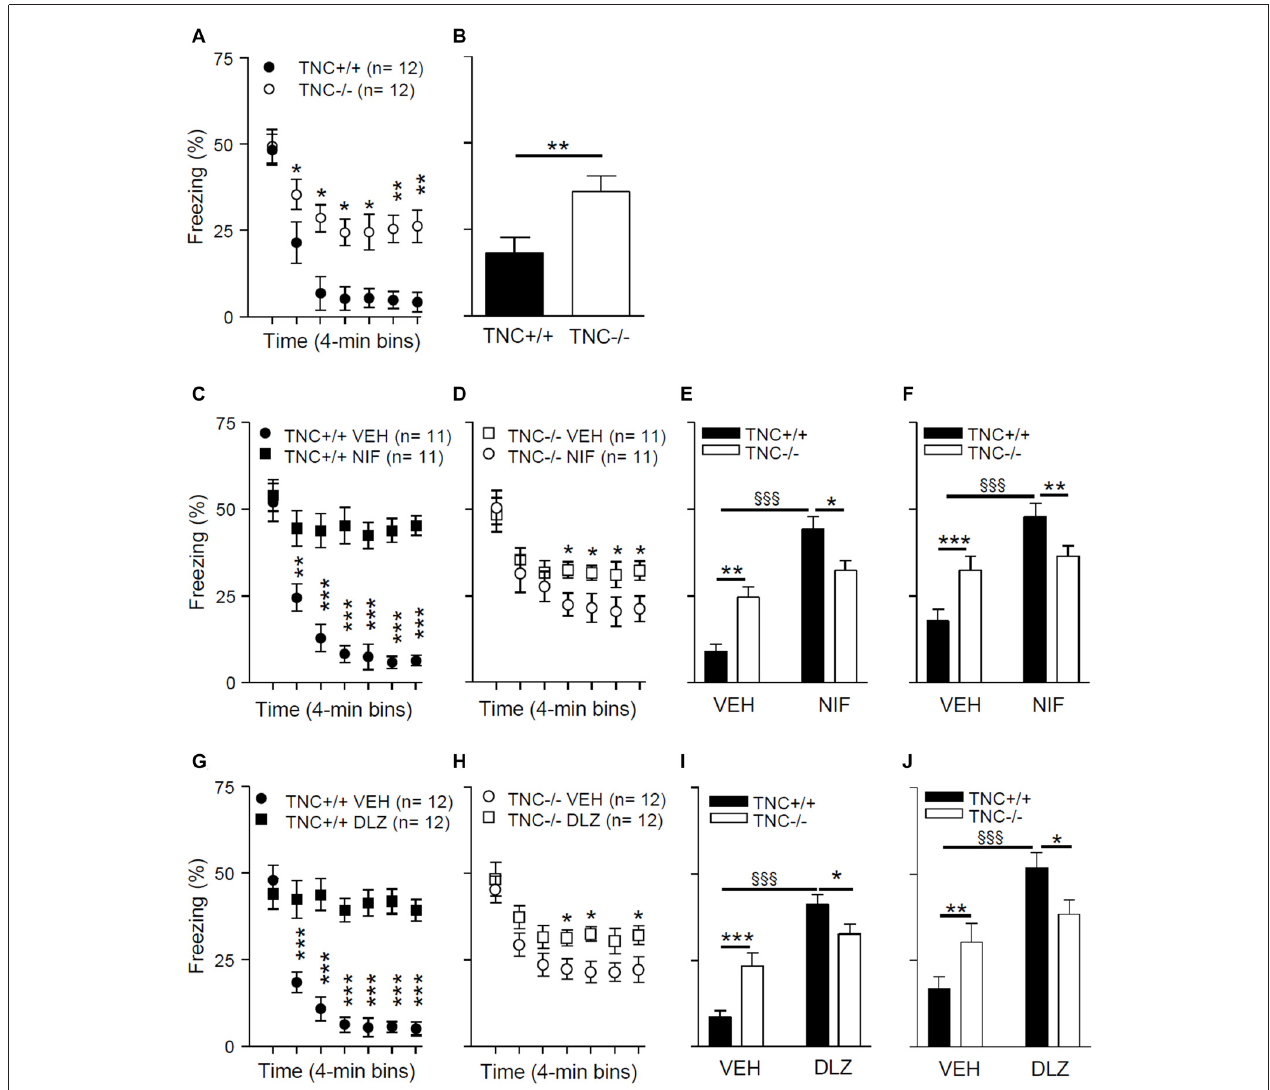
FIGURE 5 | TNC deficiency and pharmacological block of L-VGCCs inhibit the extinction of conditioned fear in mice. (A) During the extinction protocol performed on day 2, 24 h after contextual fear conditioning, TNC − / − mice spent more time freezing than TNC + / + mice. ∗ P < 0.05 compared to TNC + / + mice within the same time bin (Newman-Keuls post hoc test after mixed two-way analysis of variance (ANOVA)). (B) During the 4 min recall trial performed on day 3, TNC − / − mice spent more time freezing than TNC + / + mice. ∗ P < 0.05 compared to TNC + / + mice ( t -test). (C − F) Mice were intraperitoneally (i.p.) injected with either vehicle (VEH) or 25 mg/kg nifedipine (NIF) 20 min before the extinction trial on day 2. (C) TNC + / + mice injected with nifedipine (TNC + / + NIF) spent more time freezing starting from the 2nd time bin compared to TNC + / + mice injected with vehicle (TNC + / + VEH). ∗∗ , ∗∗∗ P < 0.01 and 0.001, respectively, compared to TNC + / + NIF mice within the same time bin (Newman-Keuls test after three-way mixed ANOVA). (D) TNC − / − NIF mice showed more freezing than TNC − / − VEH mice starting from the 4th time bin. ∗ P < 0.05 compared to TNC − / − NIF mice within the same time bin (Newman-Keuls test after three-way mixed ANOVA). (E) Time spent freezing from the 2nd to the last time bin of the extinction trial on day 2. (F) Time spent freezing during the 4 min recall trial on day 3. (G–J) Mice were i.p. injected with either VEH or 15 mg/kg diltiazem (DLZ) 20 min before undergoing the extinction trial on day 2. (G) TNC + / + mice injected with diltiazem (TNC + / + DLZ) spent more time freezing starting from the 2nd time bin compared to TNC + / + mice injected with vehicle (TNC + / + VEH). ∗∗∗ P < 0.001 compared to TNC + / + DLZ mice within the same time bin (Newman-Keuls test after three-way mixed ANOVA). (H) TNC − / − DLZ mice showed more freezing than TNC − / − VEH mice during the 4th, 5th and 7th time bins. ∗ P < 0.05 compared to TNC − / − DLZ mice within the same time bin (Newman-Keuls test after three-way mixed ANOVA). (I) Time spent freezing from the 2nd to the last time bin of the extinction trial on day 2. (J) Time spent freezing during the 4 min recall trial on day 3. In (E,F,I,J) ∗ , ∗∗ , ∗∗∗ p < 0.05, 0.01, 0.001, respectively, between TNC + / + and TNC − / − within the same treatment group. §§§ P < 0.001 between TNC + / + mice of two treatment groups (Newman-Keuls test after two-way ANOVA). Data are shown as means ±